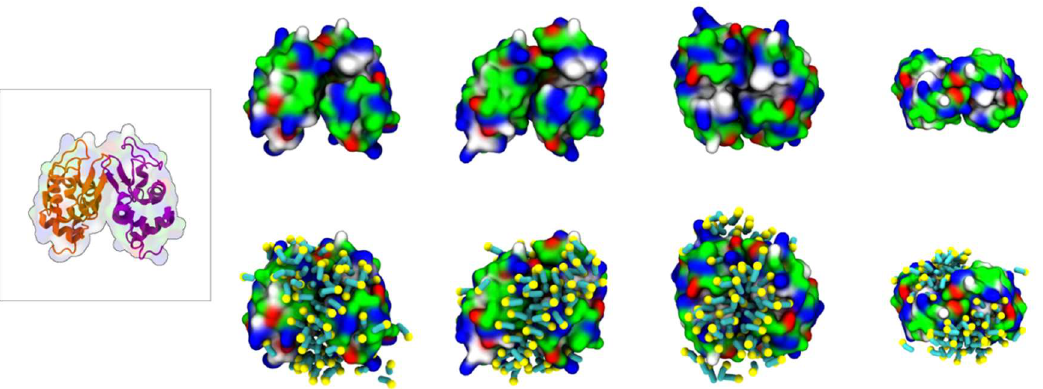
Figure 8. MD simulations of interaction between two Lys molecules and [N 1112(OH) ][C 4 F 9 SO 3 ]: atomistic structure of Lys–Lys (PDB ID:1DPX) ( left ); CG structures of Lys–Lys ( top ) and respective [C 4 F 9 SO 3 ] − micelle interactions ( bottom ). Protein surface residues are represented as polar (green), apolar (white), cationic (blue), or anionic (red).